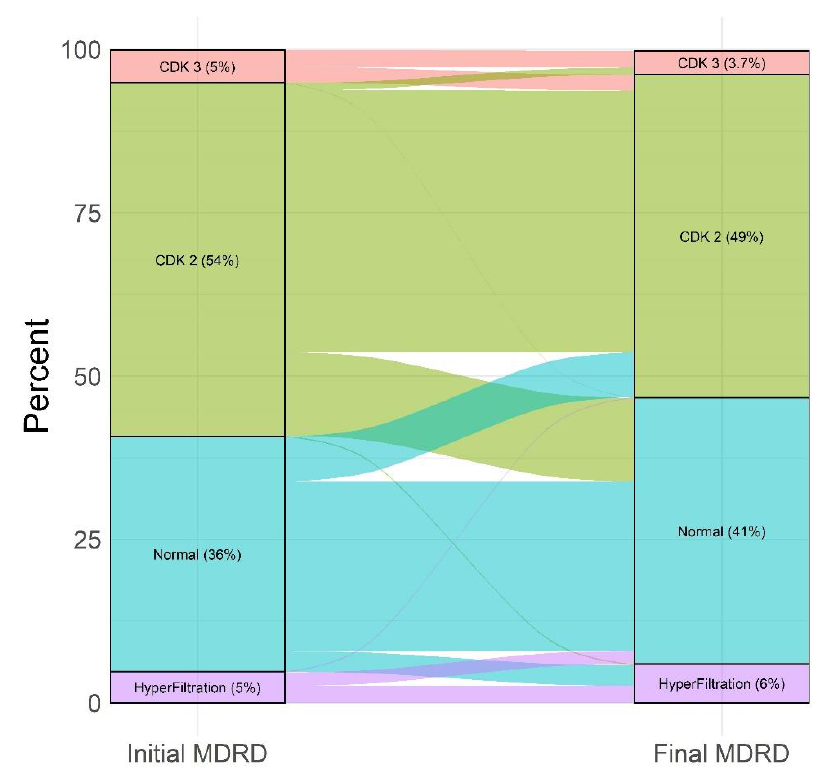
Figure 2. Changes in MDRD classes over time (%).